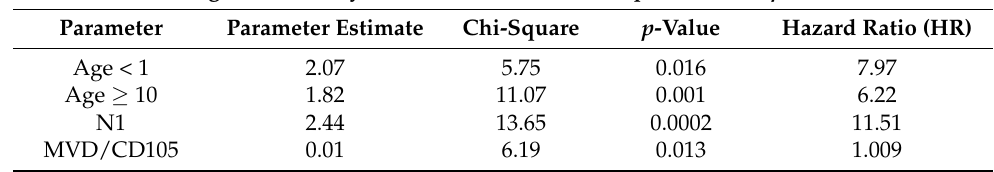
Table 4. Cox regression